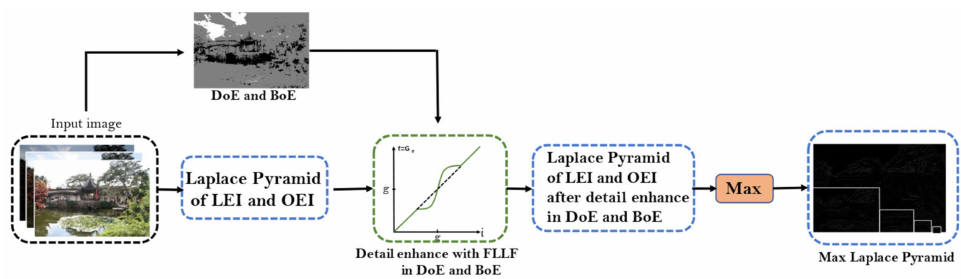
Figure 7. Local detail-enhancement